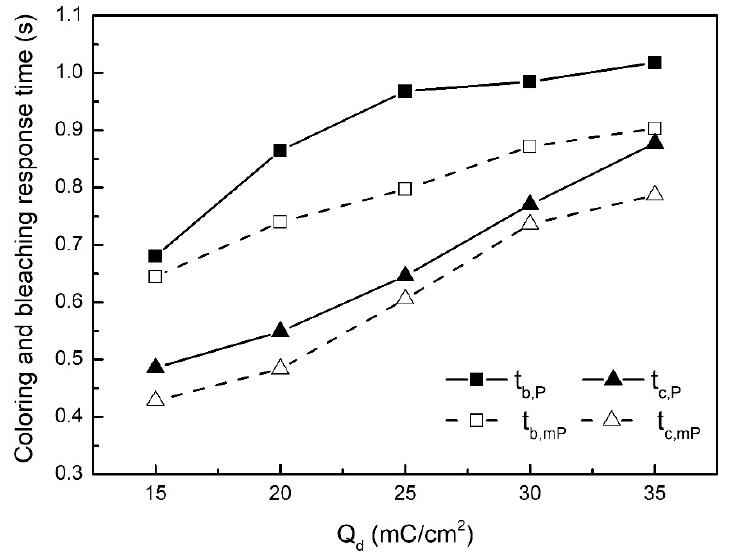
Figure 6. Comparison of the coloring and bleaching response times of the mPEDOT and PEDOT thin films prepared using different Q d ’s.